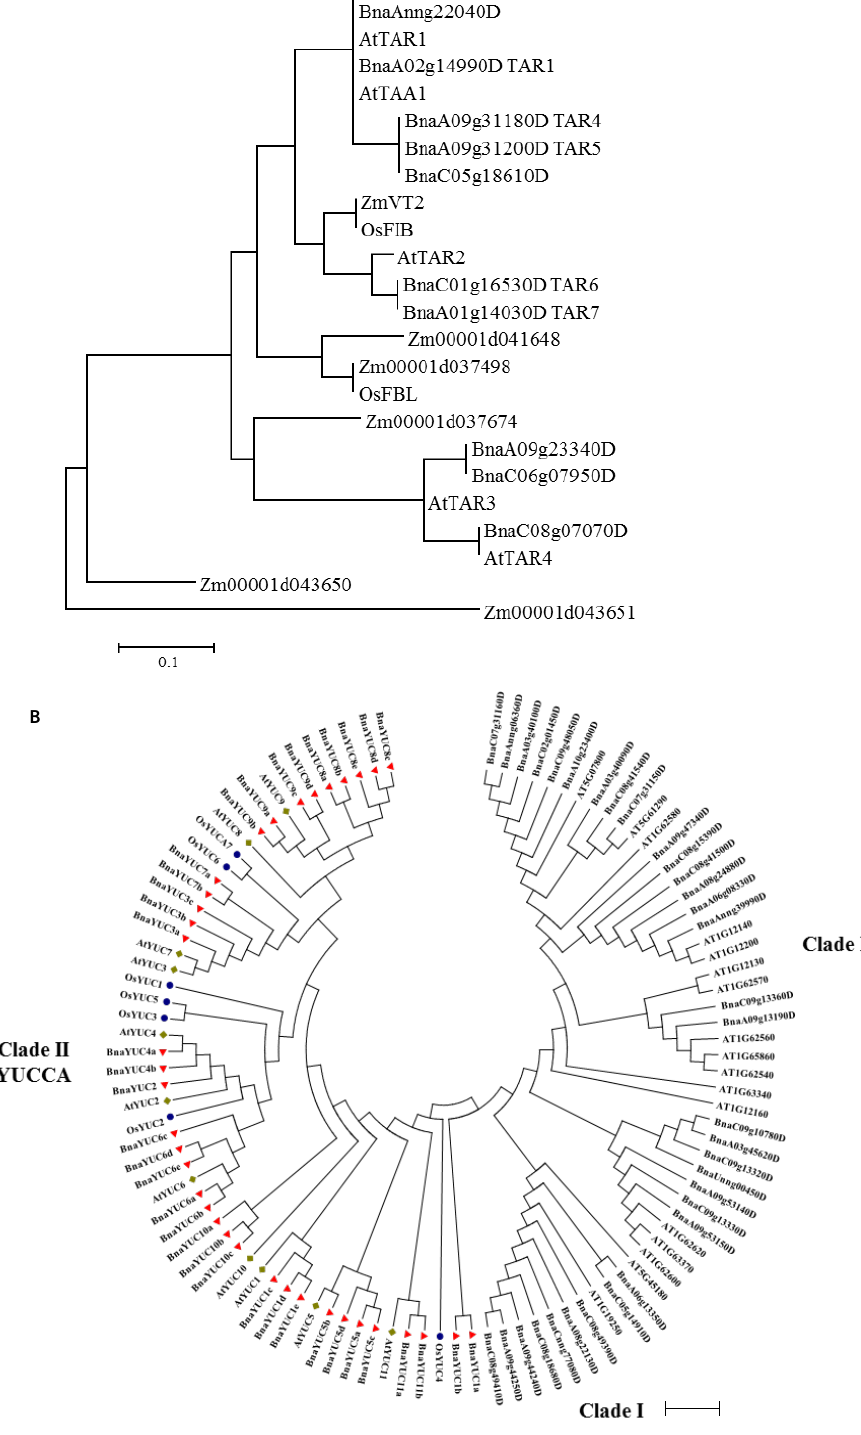
Figure 1. Phylogenetic analysis of TAR and YUC proteins: ( A ) TAR proteins from Arabidopsis, rice and rapeseed were used to construct the phylogenetic tree by using the neighbor-joining algorithm with 1000 replications. ( B ) FMO-like protein from rapeseed and Arabidopsis was used to construct the unrooted phylogenetic tree with rice YUC proteins. Proteins were divided into three clades, and clade II FMOs were in the YUC gene family. YUC proteins from rice, Arabidopsis and rapeseed were marked with circles, squares and triangles. The phylogenetic tree was constructed using the neighbor-joining algorithm with 1000 replications. Bars indicate 0.1 aa substitution per residue.